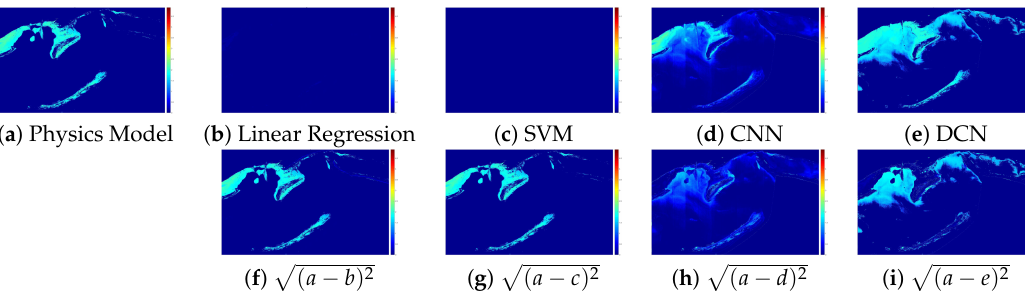
Figure 12. LAI mapping at Saint George Sound produced by our transfer learning approach using 500